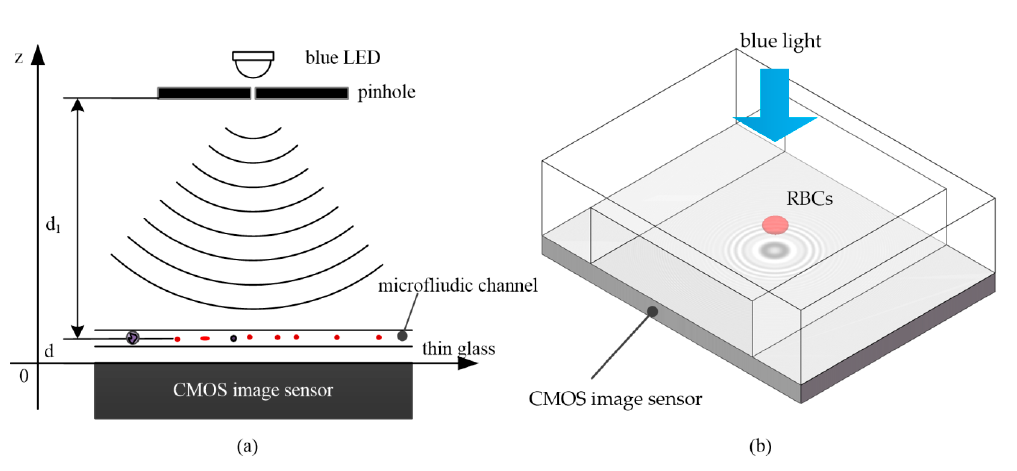
was d ( d 1 >> d ). According to the angular spectrum theory of diffraction, we can reconstruct an image